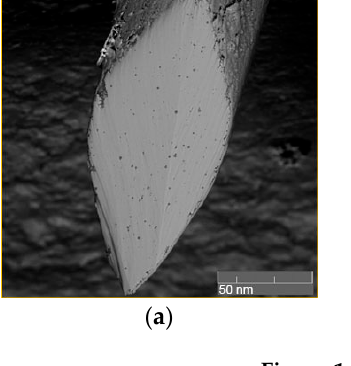
Figure 1. General view of the NiTi wire surface with a thickness of 60 µm: ( a ) cut wire; ( b ) wire surface; ( c ) distribution of elements on the wire surface.